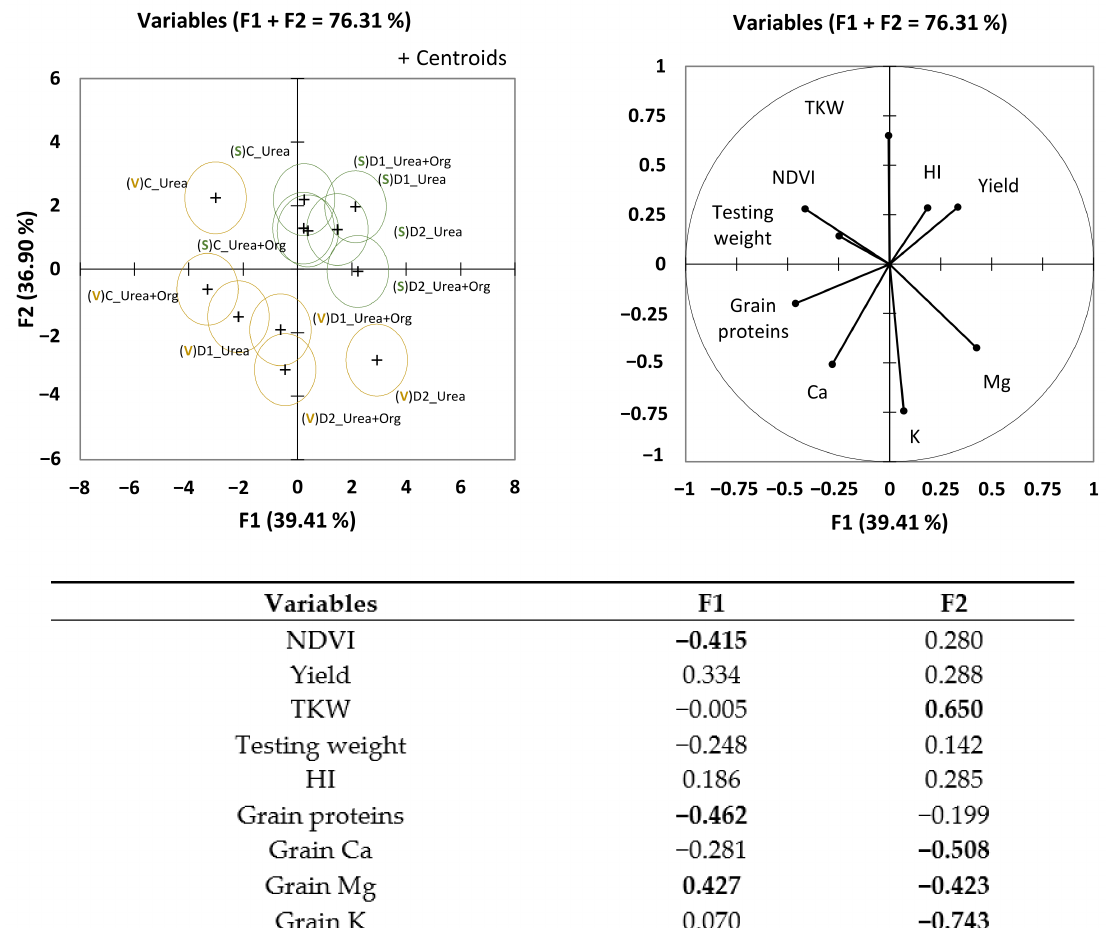
Figure 5. Multigroup discriminant analysis (MDA; left ) and principal component analysis (PCA; right ) for the yield and quality parameters, and the concentration of Ca, Mg, and K in the grains of the varieties Solehio (S, in green) and Vivendo (V, in yellow) after the biofortification treatment with D1 and D2 doses of Ca + Mg + K cations and in the two controls C_Urea and C_Urea + Org without cations. The isodensity confidence circles contain 75% variability. In the bottom table, the highly informative variables (loadings > |0.4|) are highlighted in bold, within synthetic variables F1 and F2. NDVI: normalised difference vegetation index; TKW: thousand kernel weight; HI: harvest